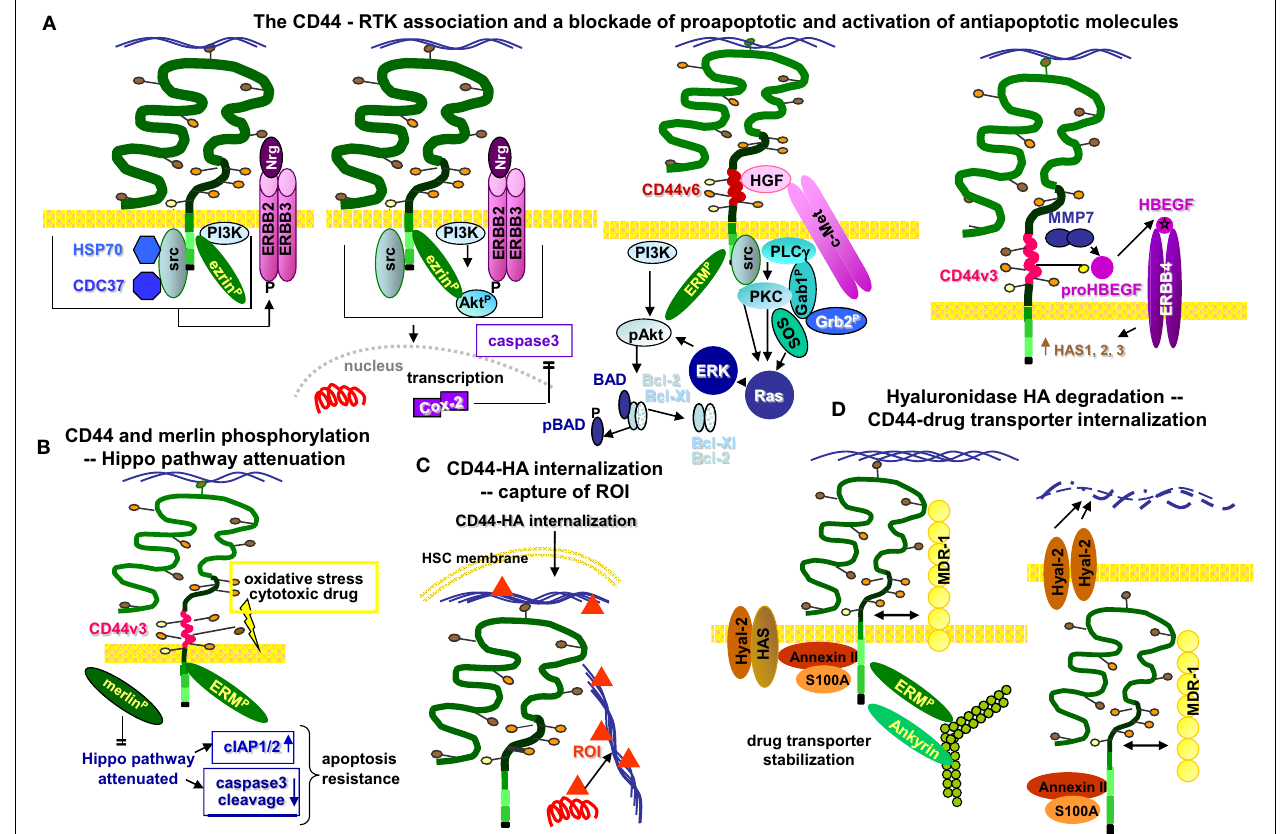
FIGURE 4 | CD44 interferes with apoptosis resistance in HSC/LIC . (A) Four major pathways of RTK-promoted apoptosis protection are shown. (i) CD44–HA binding is accompanied by activation of CD44-associated src, ezrin phosphorylation, and PI3K activation, and assembly of a complex that includes, in addition, HSP70 and the co-chaperone CDC37, which promotes phosphorylation and activation of the ERBB2/ERBB3 RTK. (ii) The CD44–ERBB2/ERBB3 complex also provides a strong stimulus for Cox-2 transcription, which interferes with caspase3 activation. (iii) CD44v6 binds HGF and presents it to MET. Activation of the latter and the downstream signaling cascades require concomitant activation of CD44 associated pERM and src. Importantly, joining of signaling via the Ras/MAPK and the PI3K/Akt pathway that rely on the CD44 cytoplasmic tail can be initiated without any additional stimuli by a CD44v6-assembled matrix. (iv) CD44v3 binds proHBEGF, which becomes cleaved via CD44-associated MMP7. HBEGF binds and activates ERBB4. All of these CD44–RTK associations strongly promote activation of signaling cascades that block apoptosis and upregulate anti-apoptotic proteins.